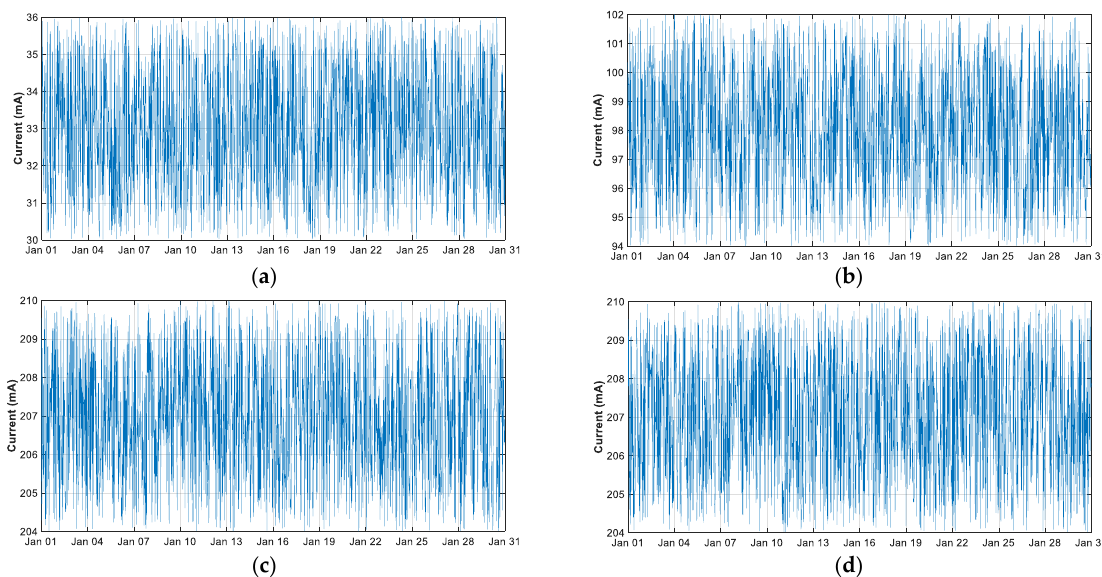
Figure 23. Consumption comparative in January 2020: ( a ) battery current with THMDL connected; ( b ) battery current with Arduino Wemos D1 mini connected; ( c ) LiPo current out with THMDL connected; and ( d ) LiPo current out with Arduino Wemos D1 mini connected.